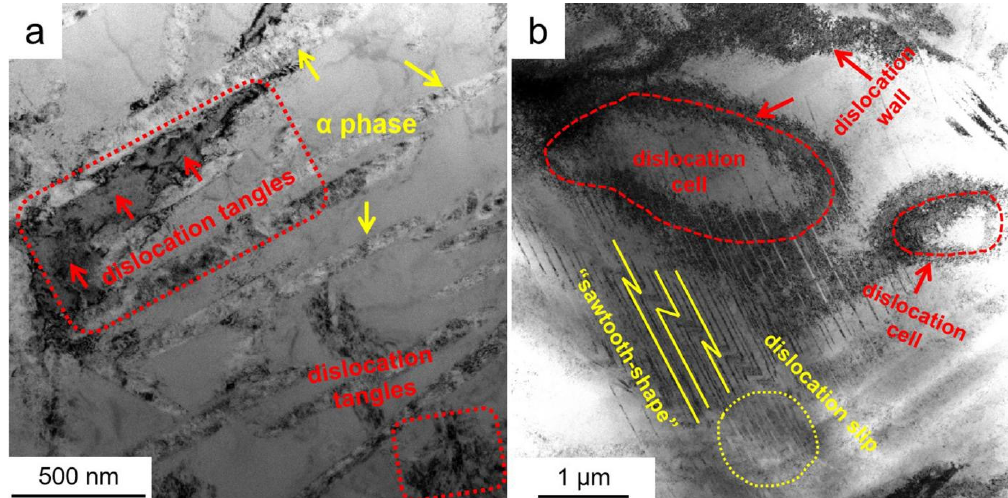
Figure 6. TEM images of dislocations in the air-cooled specimen of Ti-B12 alloy after isothermal compression: ( a ) dislocation tangles; ( b ) dislocation slip and dislocation cell.